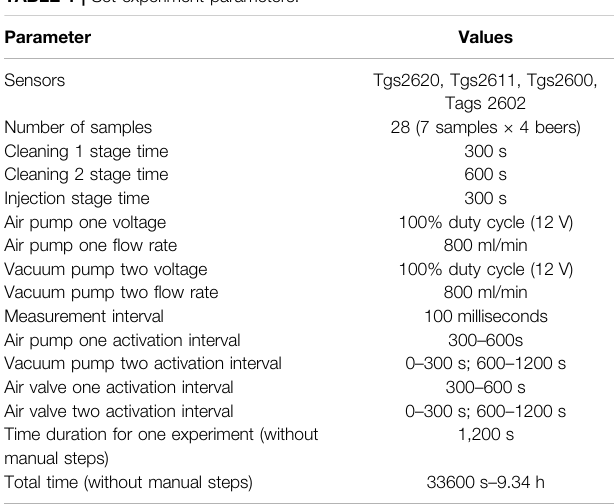
TABLE 1 | Set experiment